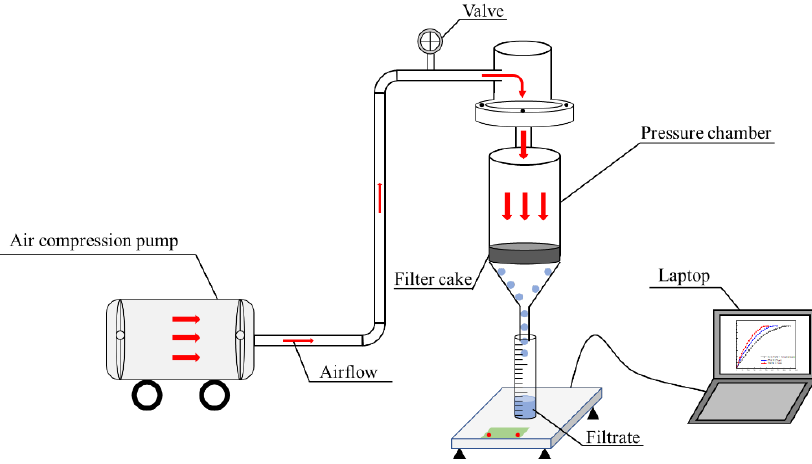
Figure 4. Schematic positive pressure filtration equipment.